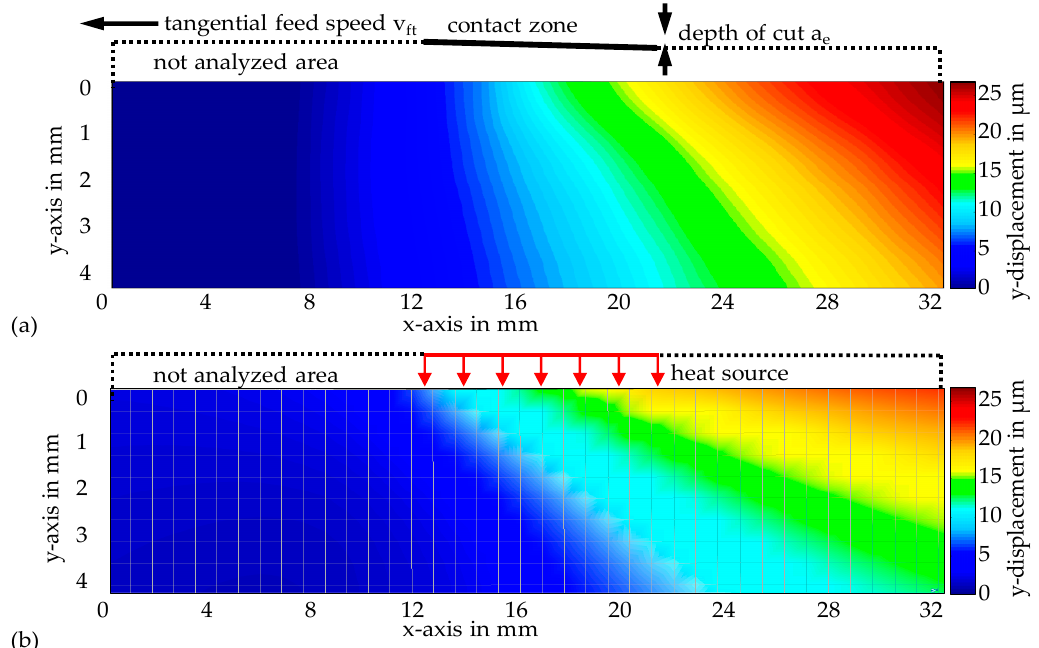
Figure 7. Total displacements during the process in normal direction: ( a ) measured with the speckle photography; ( b ) simulated.